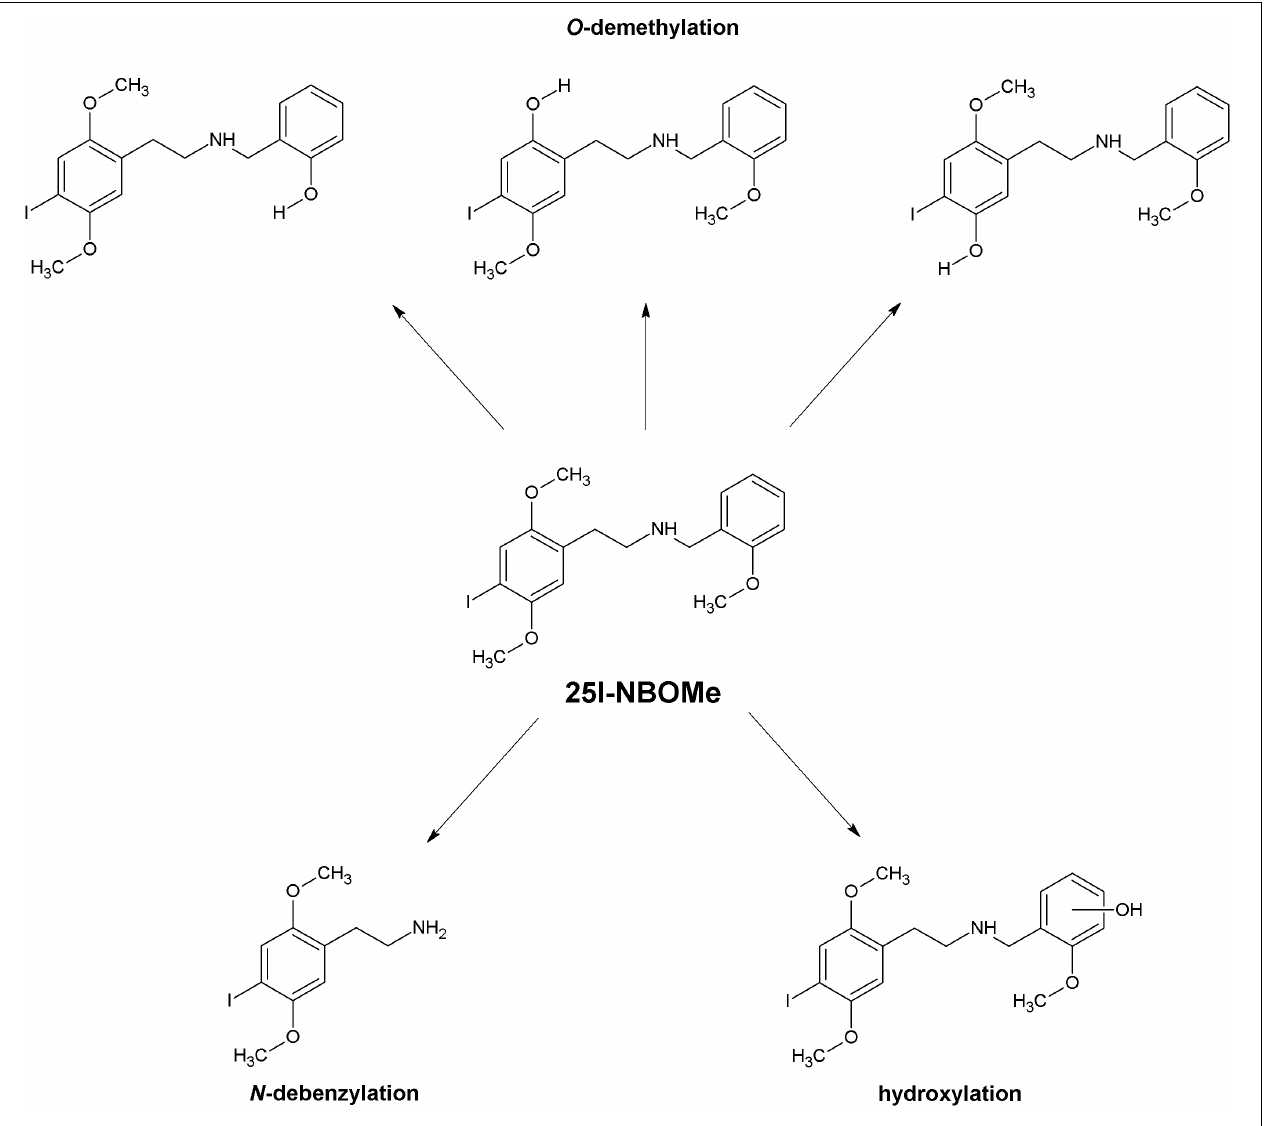
FIGURE 2 | Main phase I metabolic pathways of